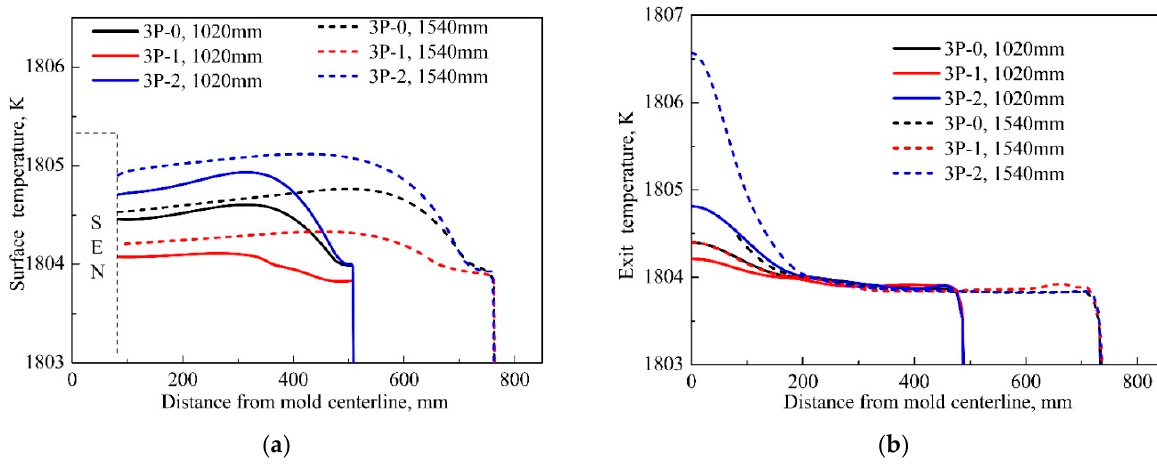
Figure 9. Temperature distribution profiles along the center-plane of wide face ( a ) on the surface and ( b ) at mold exit.